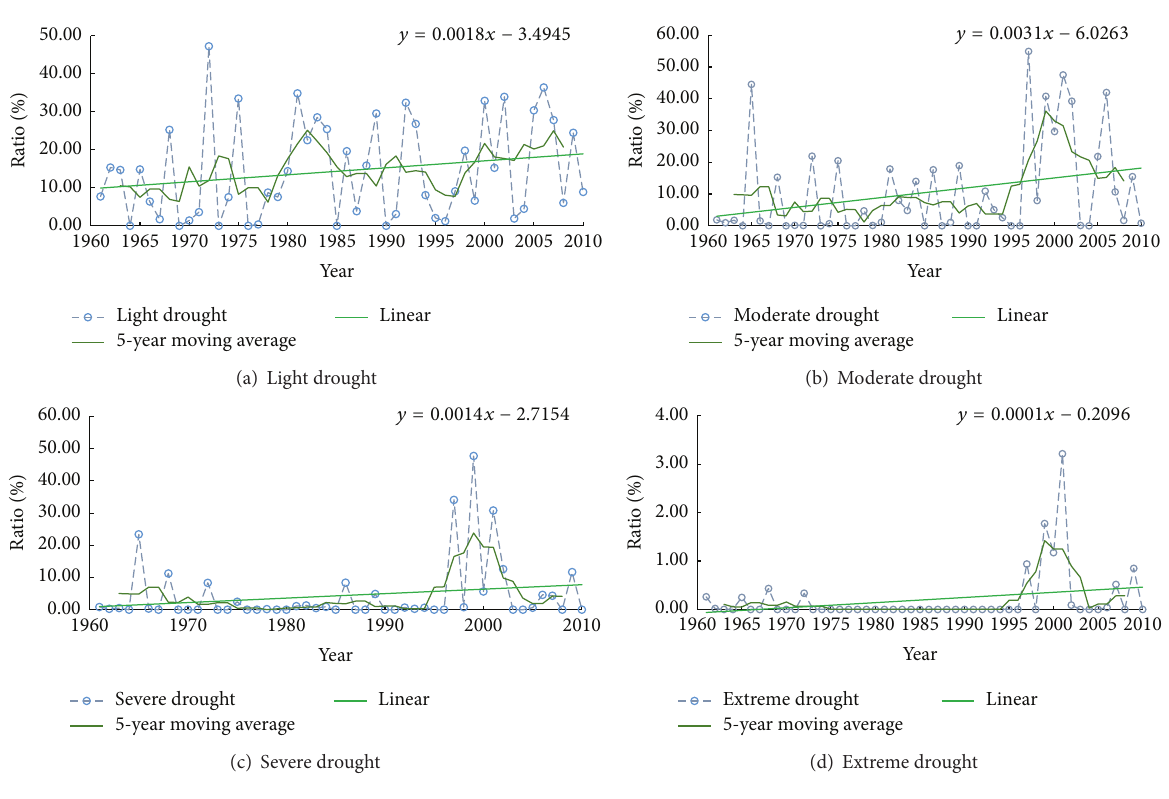
Figure 5: The interannual variability of drought area in four sublevels.